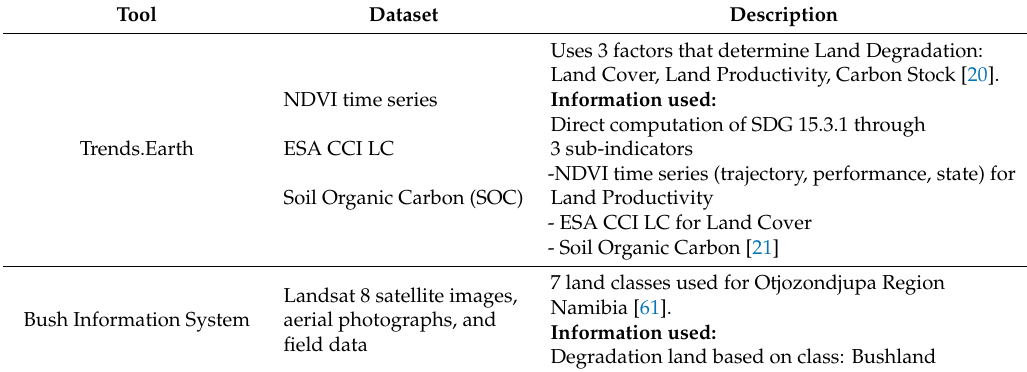
Table 4. Tools and EO data sources for the evaluation of SDG Indicator 15.3.1 (Land Degradation).